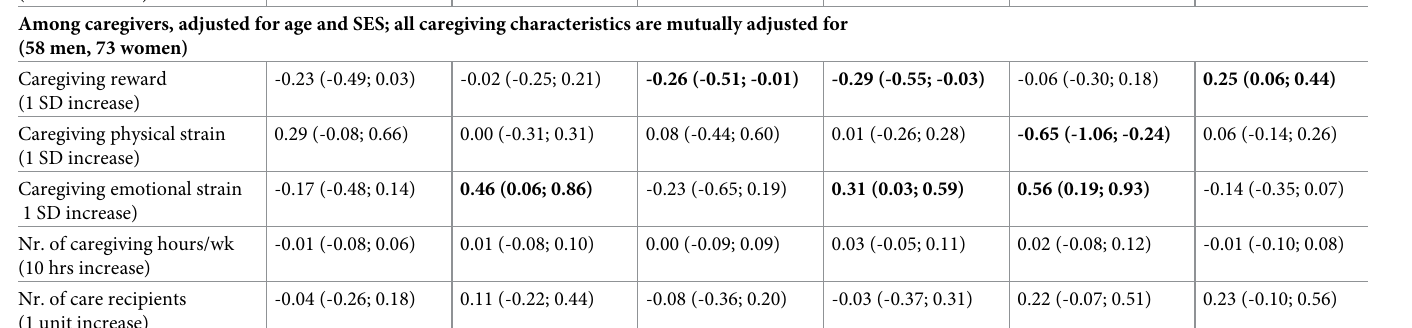
a Standardized effects are presented to enable comparison of the effect sizes between outcomes and between predictors.